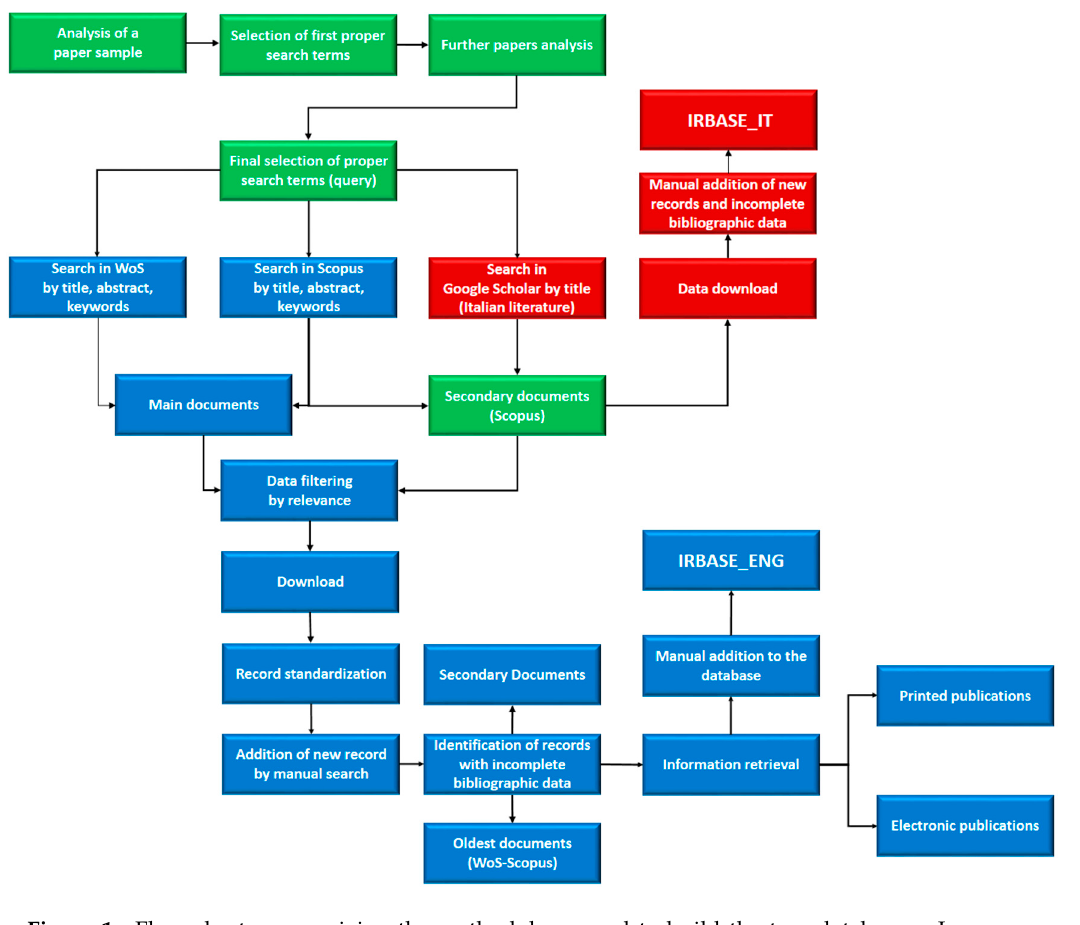
Figure 1. Flow chart summarizing the methodology used to build the two databases. In green, the methodological path common for the two databases. In blue, the path followed only for assembling IR_BASE_ENG. In red, the path for the building of IR_BASE_IT.